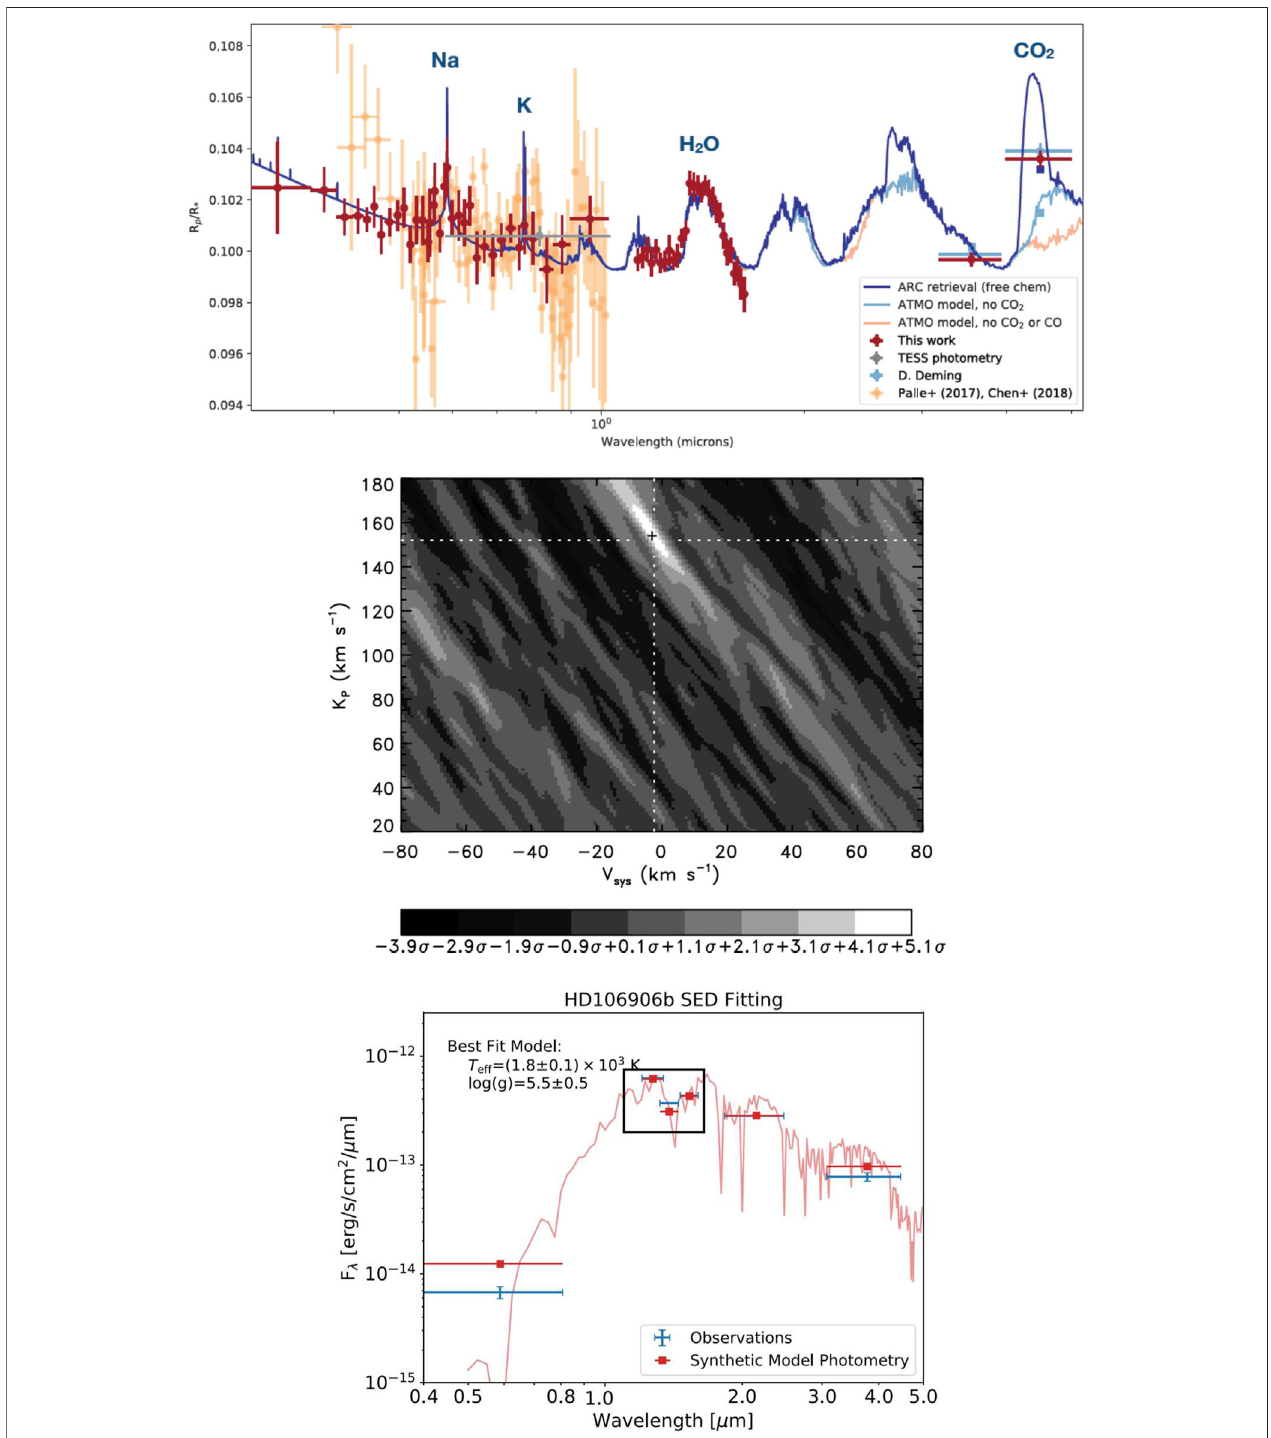
FIGURE1| Detection ofwater inexoplanets:Top, Transmission (Hubble Space Telescope and Spitzer) spectrum oftransitingexoplanetWasp-127b (reproduced fromFigure18ofSpakeetal.,2020);Middle,high-resolutiondetectionofwaterinwithsigni fi canceof4.8 σ (reproducedfromFigure3ofBirkbyetal.,2013);Bottom, fi rst 1.4 μ m water band photometric measurement for HD 106906 by Zhou et al., 2020. (©AAS. Reproduced with permission.)